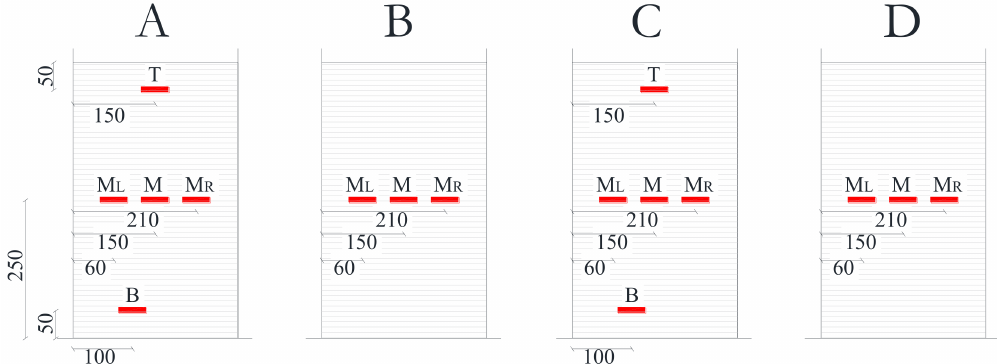
Figure 6. Strain gauges scheme on CFRP sheets.